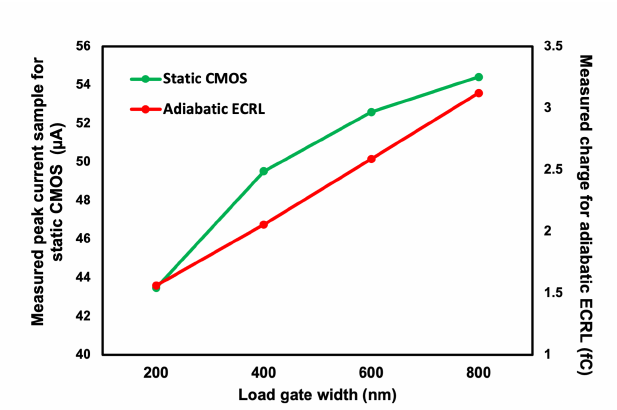
Figure 11. Dependence of peak current and charge drawn by the driving gate on target load capacitance for static CMOS and adiabatic ECRL.